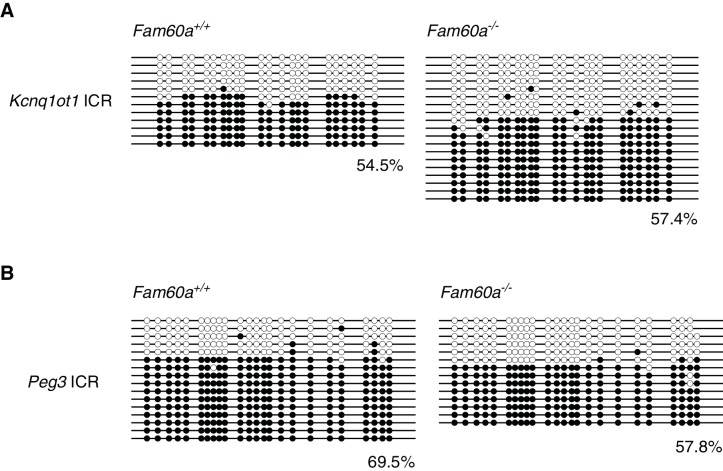
Methylation status of imprinting control regions as determined by bisulfite sequencing.The methylation status of the imprinting control regions (ICRs) of Kcnq1ot1 (A) and Peg3 (B) was determined in individual WT and Fam60a–/– embryos at E9.5.